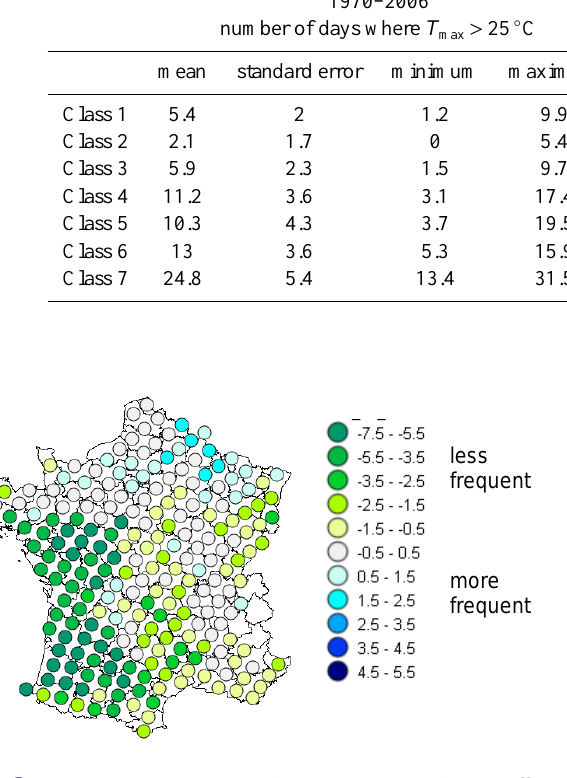
Figure 3. Agro-climatic indicator for the decrease of soil tra ffi - cability for early grazing, defined as 5 days with rainfall higher than 60mm at the beginning of spring (500 ◦ C.day after 1 Febru- ary). Number of years among 10 when more (positive values) or less (negative values) unfavourable conditions will occur in the dis- tant A2 scenario.